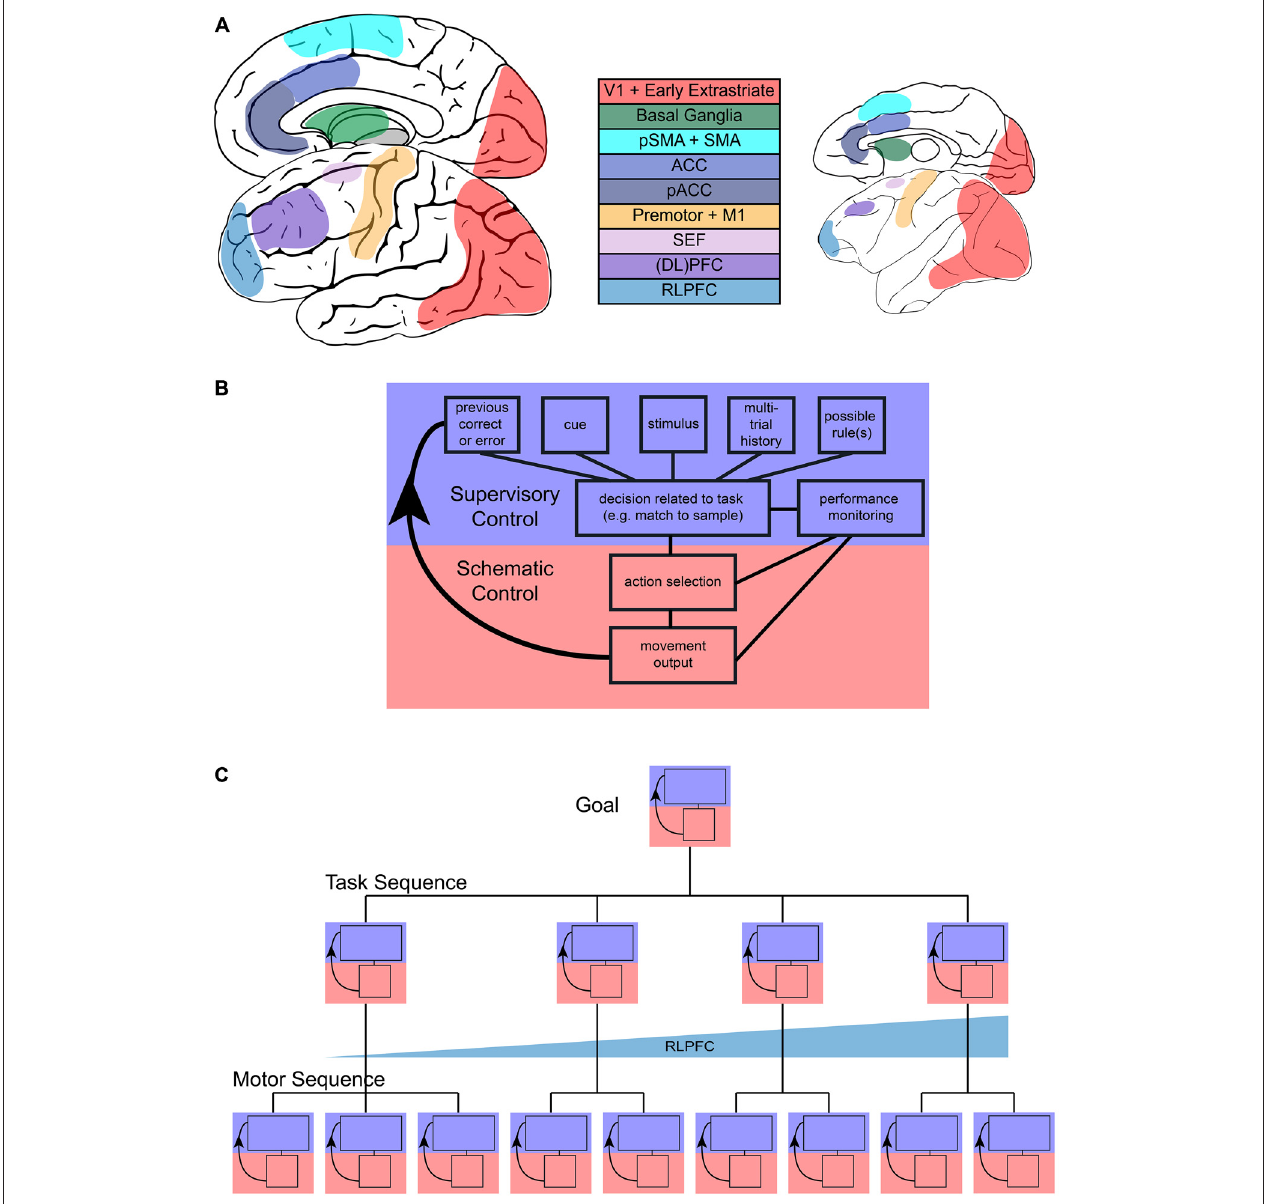
FIGURE 1 | Sequential task control schematic. (A) Representation of main areas involved in sequential control in the human (left) and monkey (right) brain. (B) Flow of control in one step of a sequential task, with blue representing the increased involvement of supervisory control and red representing increased involvement of schematic control during a single step. (C) Representation of the multiple, hierarchical levels that can characterize sequences. Each step in more concrete motor sequences or more abstract task sequences may engage supervisory or schematic control and the interaction between them. Tracking across tasks in a task sequence may be accomplished by rostrolateral prefrontal cortex (RLPFC) ramping across multiple